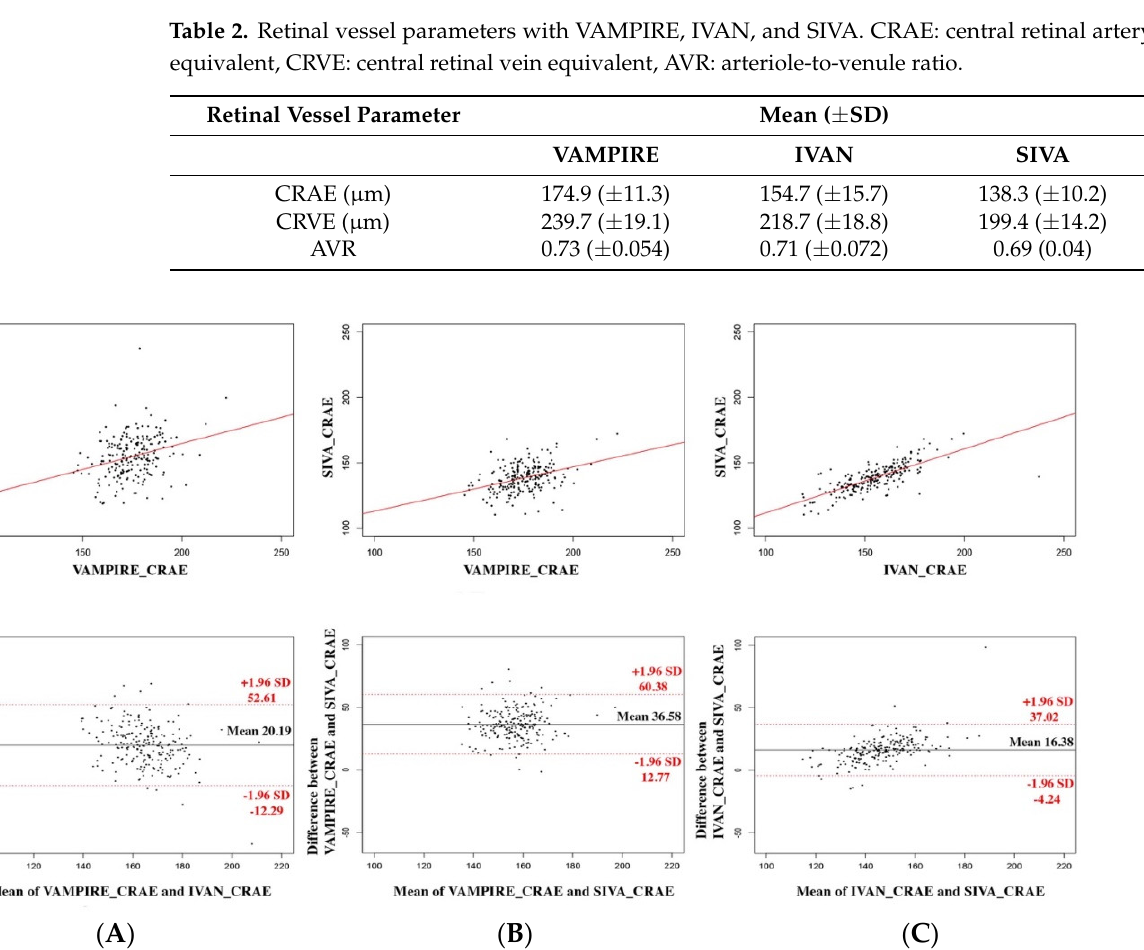
Table 2. Retinal vessel parameters with VAMPIRE, IVAN, and SIVA . CRAE: central retinal artery